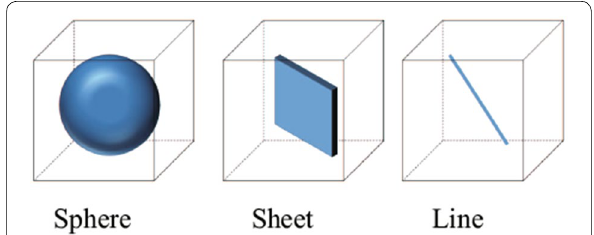
Fig. 3 Classification of point distribution in an ND